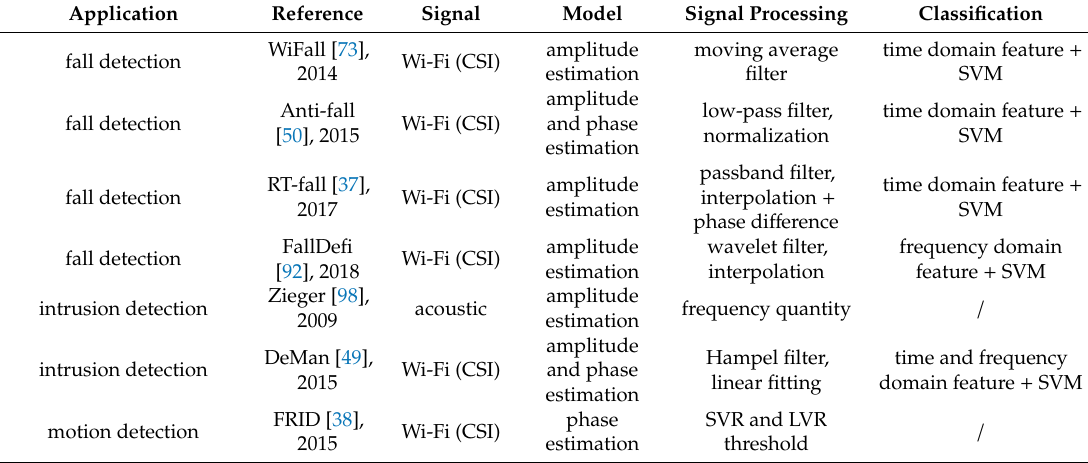
Table 9. Summary of wireless sensing applications: